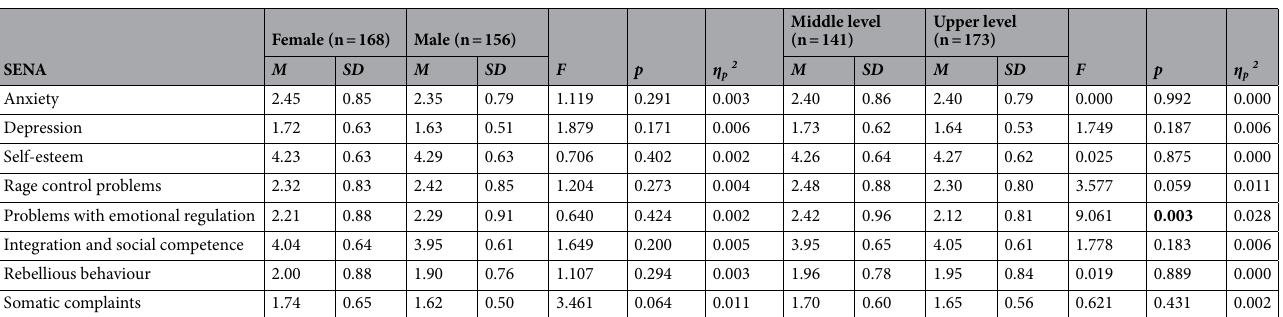
Table 4. Differences by gender and educational level in the mental health of children between 8 and 12 years old during confinement. Statistically significant differences ( p < .05) are highlighted in bold. The middle level comprises 3rd and 4th elementary (8–10 years old). The upper level 5th and 6th elementary (10–12 years).